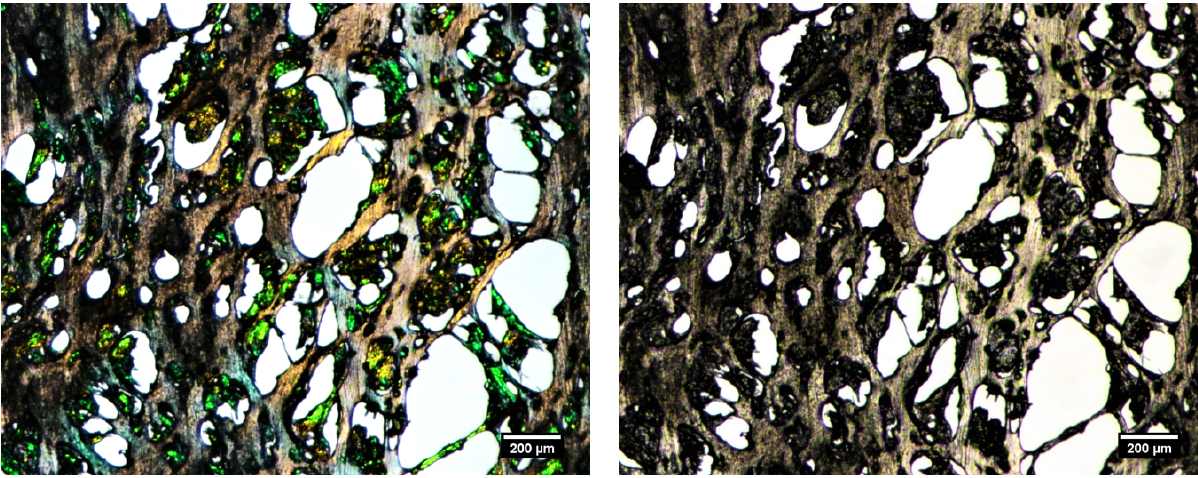
Figure 5: Microscopic images of a 40 µ m – slice from an extruded soy protein – MC matrix (T Material = 125 ∘ C, n = 250 rpm). Images taken with (left) and without (right) polarization filter in a conventional light